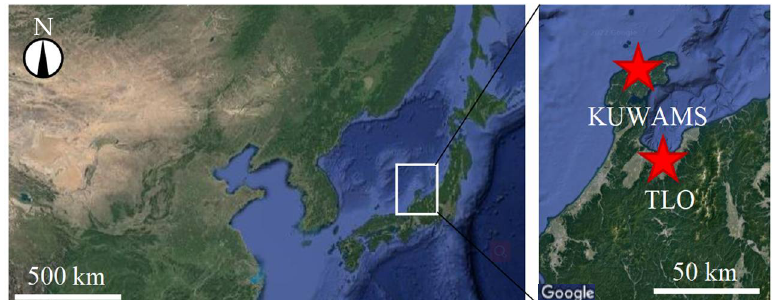
Figure 1. Location of Kanazawa University Wajima Air Monitoring Station (KUWAMS; 37.4° N, 136.9° E) and Toyama Light Detection and Ranging Observatory (TLO; 36.70° N, 137.10° E) (used with permission. Google map: https://www.google.com/maps, accessed on 5 July 2022).